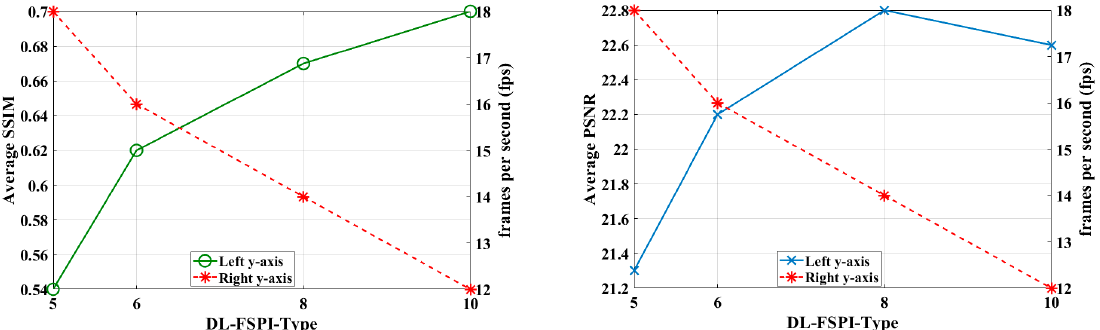
Figure 9. Quantitative comparison of DL-FSPI methods at different sampling rates.